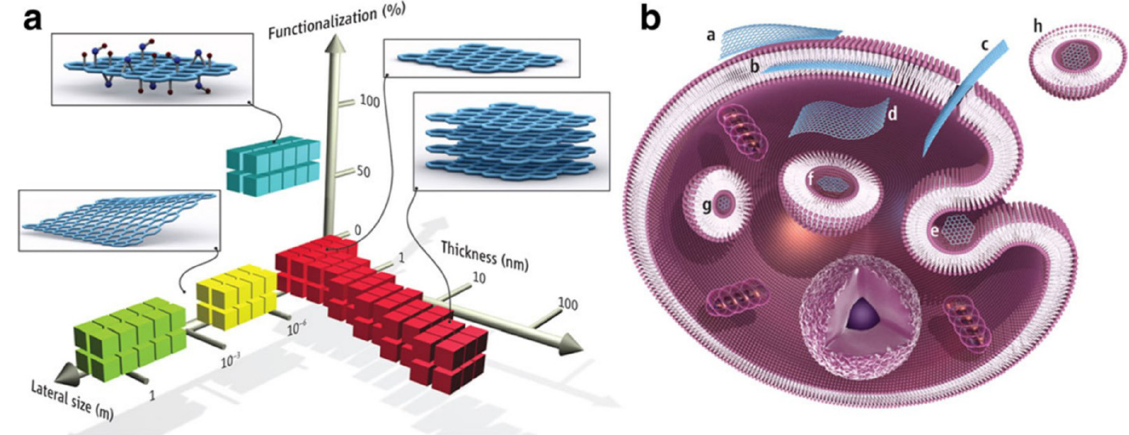
Figure 17. ( a ) CBM can be described by the dimensions and surface functionalization of the material (percentage of the carbon atoms in sp 3 hybridization). Green squares represent epitaxially grown graphene; yellow, mechanically exfoliated graphene; red, chemically exfoliated graphene; blue, GO. ( b ) Possible interactions between CBM with cells (a) Adhesion onto the outer surface of the cell membrane. (b) Incorporation in between the monolayers of the plasma membrane lipid bilayer. (c) Translocation of the membrane. (d) Cytoplasmic internalization. (e) Clathrin-mediated endocytosis. (f) Endo- somal or phagosomal internalization. (g) Lysosomal or other perinuclear compartment localization. (h) Exosomal locali- zation. The biological outcomes from such interactions can be considered to be either adverse or beneficial, depending on the context of the particular biomedical application. Different CBM will have different preferential mechanisms of inter- action with cells and tissues that largely await discovery. Reproduced from Ref. [135] with permission from the American Association for the Advancement of Science.